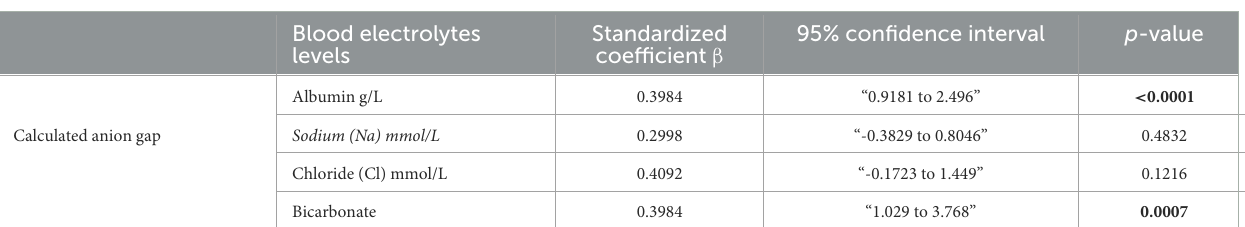
TABLE 3 Multiple regression analysis.